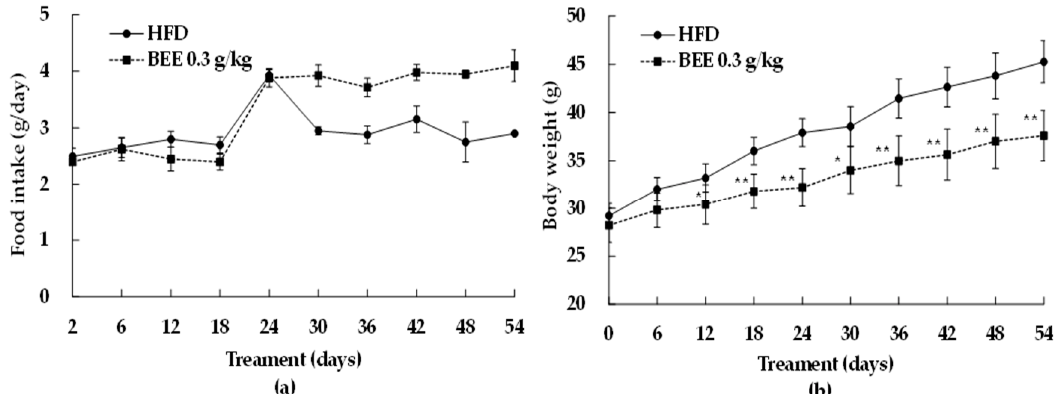
Figure 2. Changes in food intake ( a ) and body weight gains ( b ) before/after administration of BEE. Male C57BL/6 mice had free access to a high fat diet (HFD) (30% fat) to induce the weight gain for 54 days. During an HFD administration for 54 days, BEE was orally administrated (0.3 g/kg-body weight/day, peroral zonde injection) to BEE group C57BL/6 mice, 2 times per day (9–10 a.m. and 4–5 p.m.) with 0.15 g/kg-body weight each. Ten C57BL/6 mice were used for each group. Each point represents mean ± S.D. ( n = 10). Food intake and body weight levels were compared between control (HFD) and treatment group (BEE) at each time point by unpaired Student’s t -test (* p < 0.05; ** p < 0.01; *** p < 0.001).